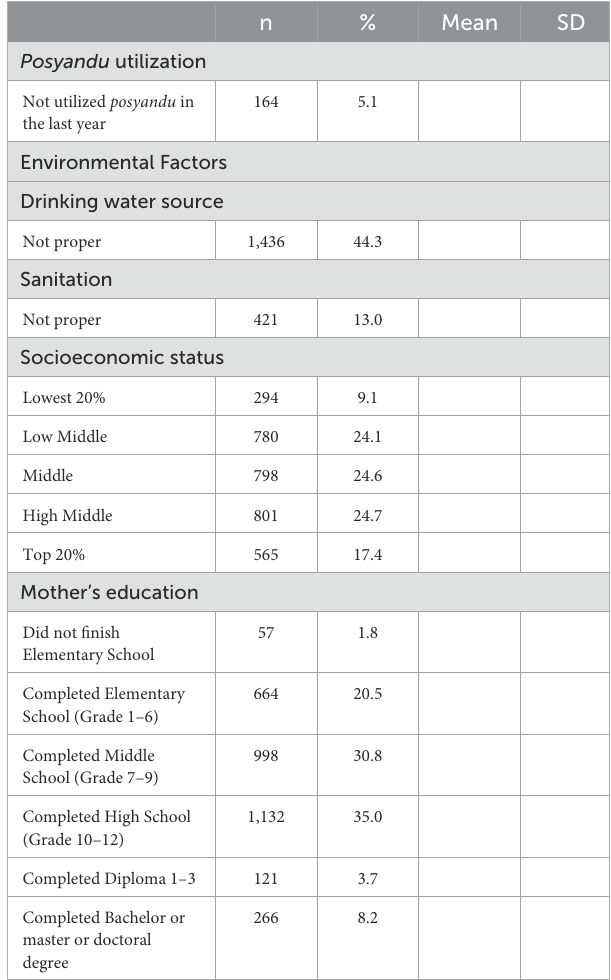
TABLE 1 Descriptions of characteristics, direct, indirect, and underlying factors of LAZ scores among children aged 6–23 months old in Central Java province based on INSS 2021 ( n =